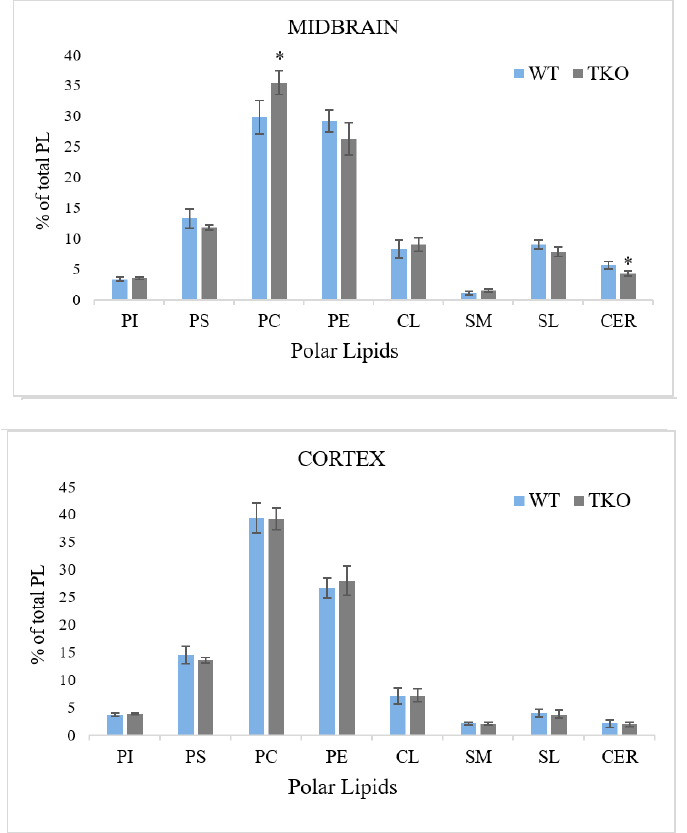
Figure 5. Midbrain and cortex polar lipid composition (% of total polar lipids) from wild-type (WT) and triple-synuclein null mutant (TKO) mice. Means ± s.d. ( n = 5 for WT cortex; n = 6 for WT midbrain and both regions of TKO) are shown. * p < 0.05. Abbreviations: PI, phosphatidylinositol; PS, phosphatidylserine; PC, phosphatidylcholine; PE, phosphatidylethanolamine; CL, cardiolipin; SM, sphingomyelin; SL, sulfatide; CER, cerebroside.